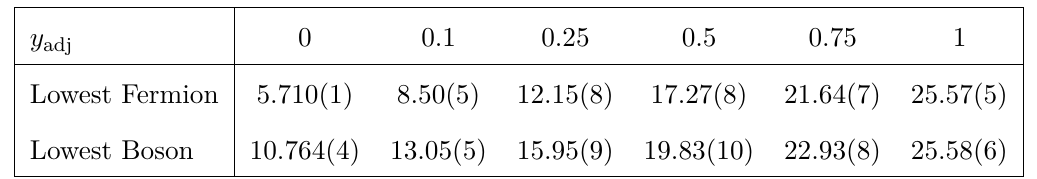
Table 3 . Some values of πM 2 for the lowest fermion and lowest boson in the SU(2) theory, as given g 2 N in figure 3. Errors are estimated by taking an ensemble of extrapolations to K → ∞ calculated using subsets of 10 or more consecutive points between K = 30 and K = 60 , and taking the standard deviation of the extrapolated